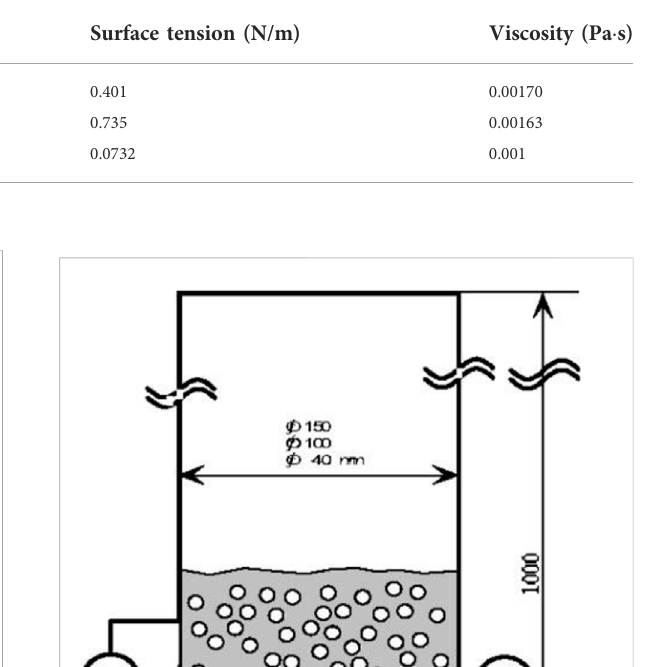
TABLE 3 Physical property parameter of liquid in the experiment.